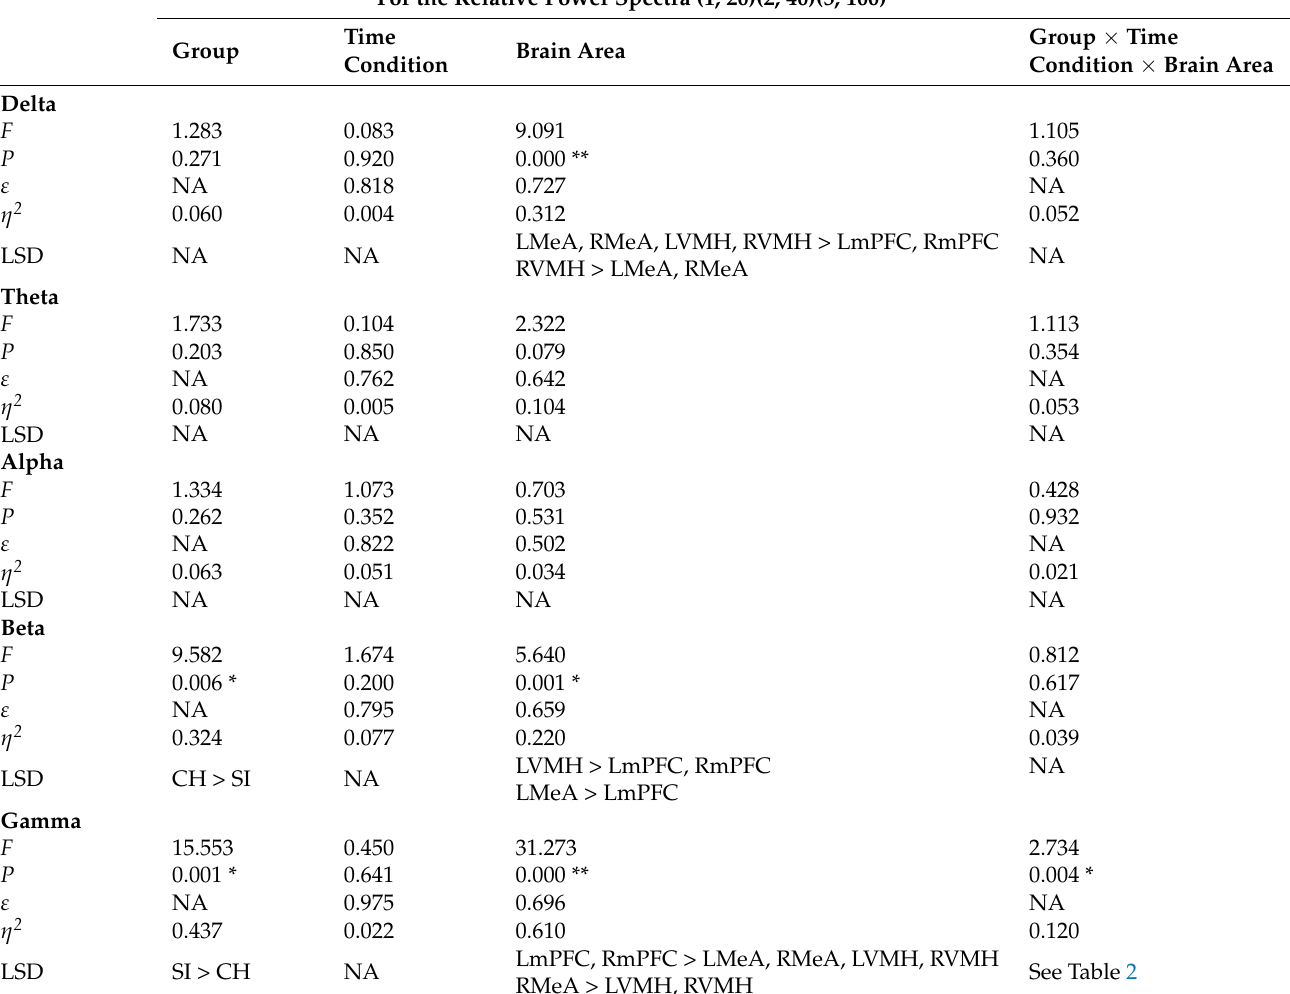
Table 1. Results of AVOVA for the factors “group”, “time condition” and “brain area” for the five EEG